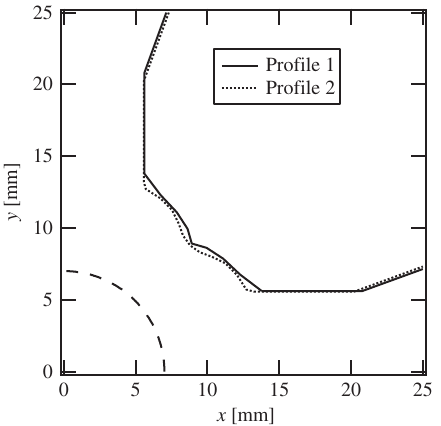
FIG. 10. 12-pole term vs current, for Profile 1 and Profile 2. Reference radius: 7